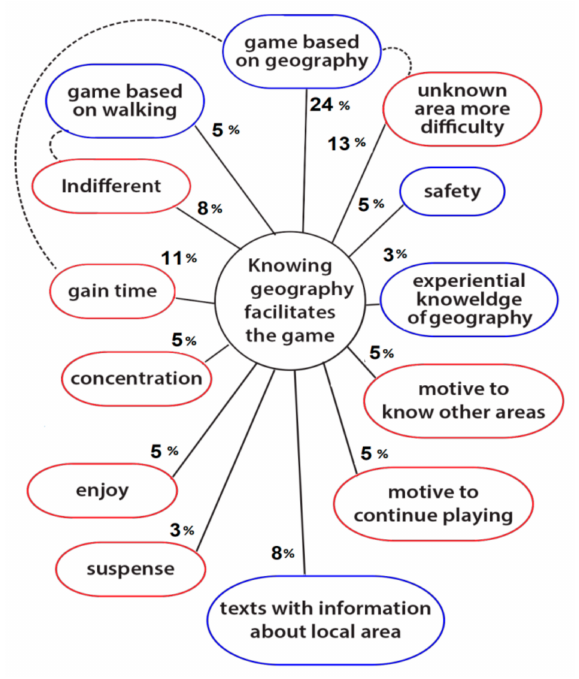
Figure 1. Subthemes resulting from the content analysis of the responses to question 1. Percentages correspond to the number of mentions related to the main thematic “knowing geography facilitates the game”. Some subthemes were mentioned more than once by the participants. who also mentioned the subthemes that are connected with dotted lines. Subthemes in red relate to the user, while those in blue relate to the